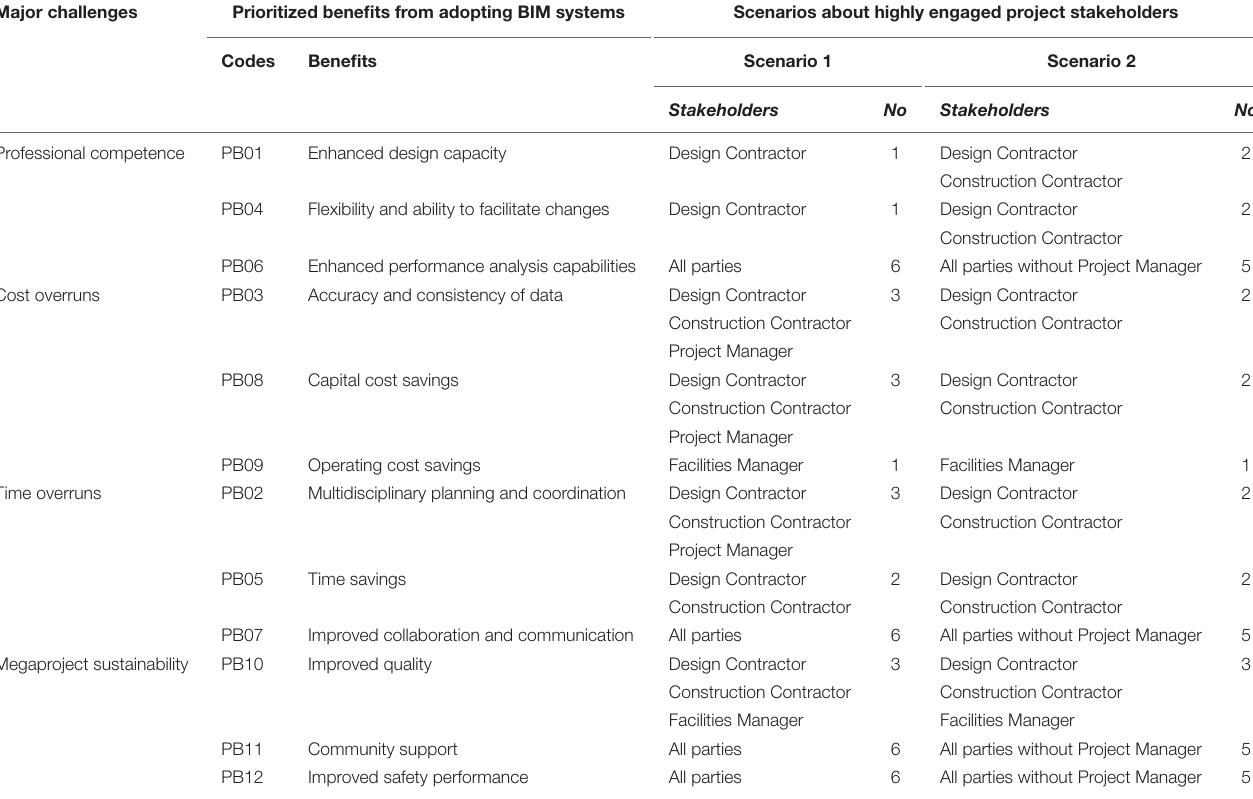
TABLE 11 | Major challenge oriented scenarios for analyzing prioritized BIM benefits on